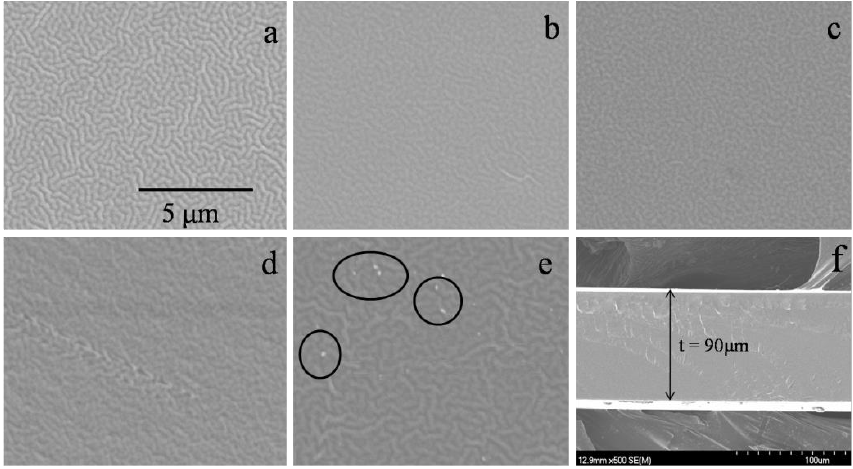
Figure 2. SEM images of different films: ( a ) pure PVA, ( b ) P-40, ( c ) P-40-5, ( d ) P-40-10, ( e ) P-40-15, and ( f ) cross-section of P-40-10.